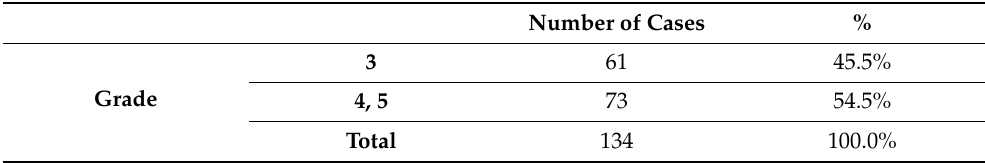
Table 1. Descriptive statistics regarding Gleason grade pattern in our prostate cancer cases. Number of